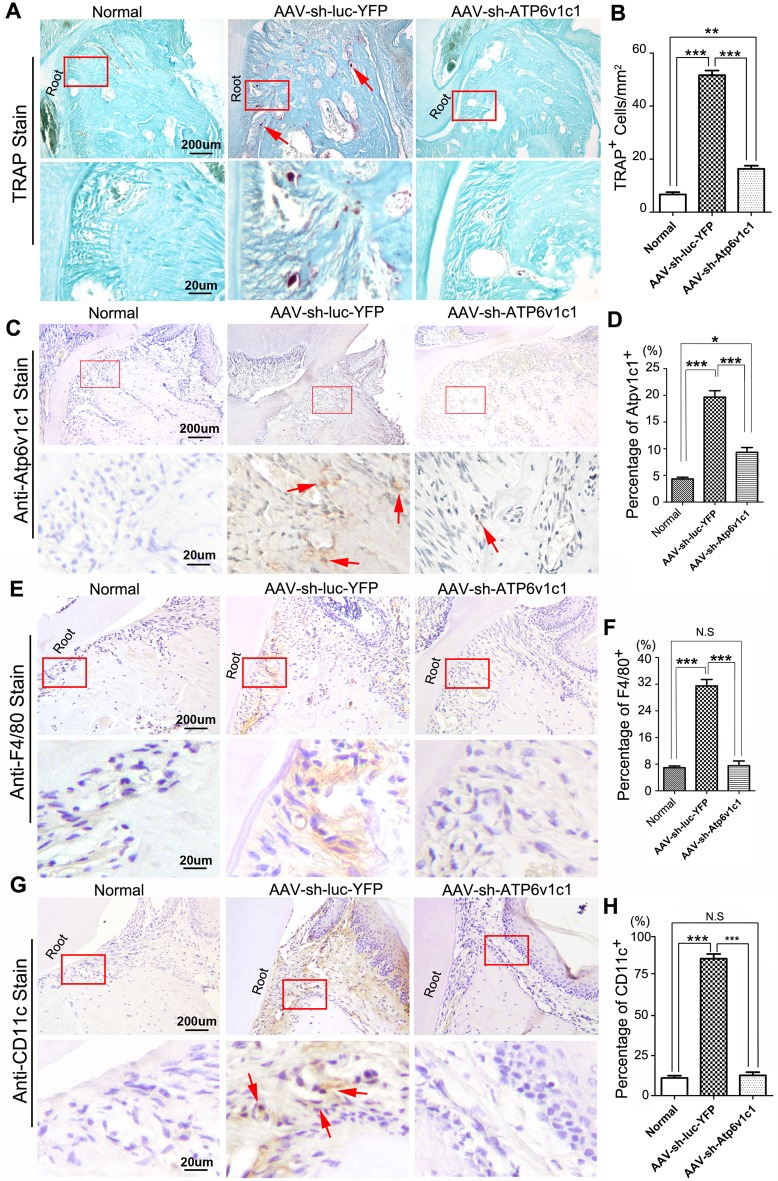
AAV-mediated Atp6v1c1 knockdown decreased TRAP positive cells and Atp6v1c1 expression in the periodontitis lesion area.(A) TRAP staining was used to indicate the decrease in Atp6v1c1 expression in periodontal tissues after AAV-sh-Atp6v1c1 knockdown. The number of osteoclasts decreased significantly (Red arrows). Mature osteoclasts could be found frequently under microscope with higher magnification. (B) Statistical analysis indicates that in the AAV-sh-Atp6v1c1 treatment group, the number of osteoclasts was reduced significantly. (C) Immunohistochemical staining was used to verify the effectiveness of AAV-sh-Atp6v1c1 knockdown in periodontal tissues (Red arrows). (D) Statistical analysis indicates that in the AAV-sh-Atp6v1c1 treatment group, the number of Atp6v1c1 positive cells was reduced significantly. (E) Immunohistochemical staining of F4/80 was applied to the different groups in the periodontitis lesion area. (F) Statistical analysis indicates that the number of F4/80 positive cells was reduced significantly in the AAV-sh-Atp6v1c1 treatment group. (G) Immunohistochemical staining of CD11c was applied to the different groups in the periodontitis lesion area (Red arrows). (H) Statistical analysis indicates that the number of CD11c positive cells was reduced significantly in the AAV-sh-Atp6v1c1 treatment group.*: P < 0.05, **: P < 0.01, ***: P<0.001, N.S: No Significance.